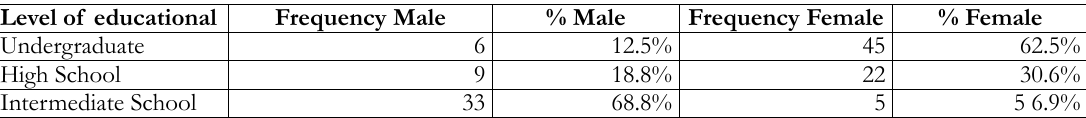
Table 1. Descriptive statistics for demographic Level of